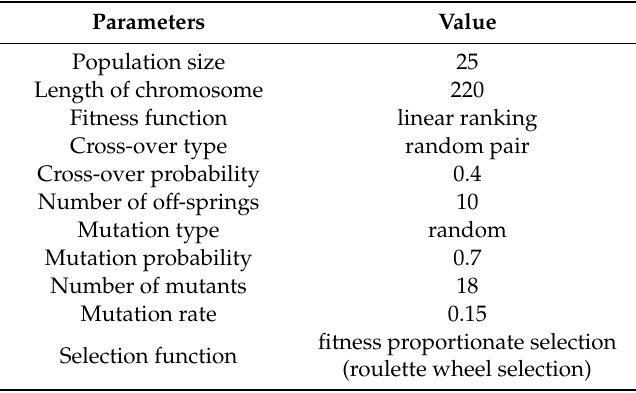
Table 2. Parameters of Genetic Algorithm (GA) used in this